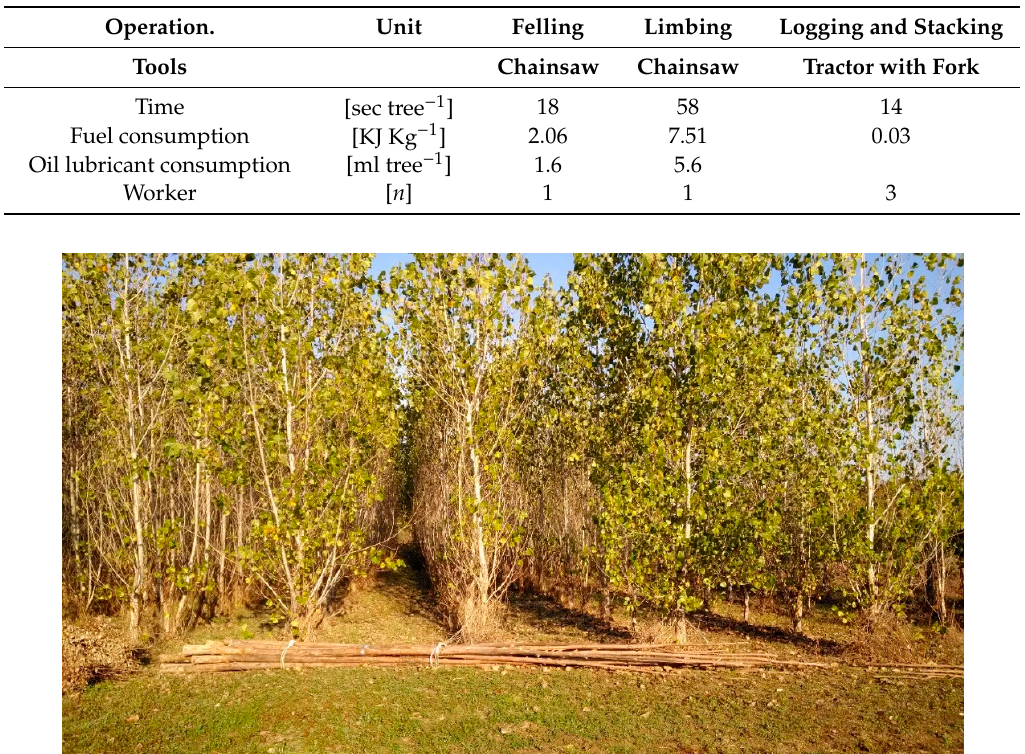
Table 2. Description of the operation time and consumption during the harvesting of Eucalyptus spp. plants in MRC.